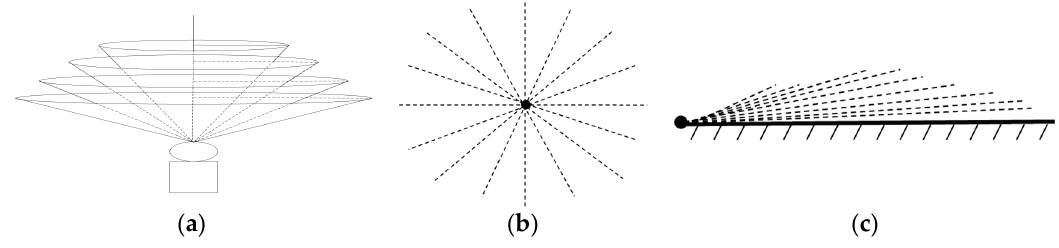
Figure 13. The spatial distribution of the raw radar data. ( a ) A stereo view; ( b ) A vertical view; ( c ) A side view.